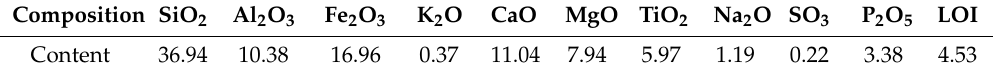
Table 2. Chemical composition of iron tailings sand (wt%).